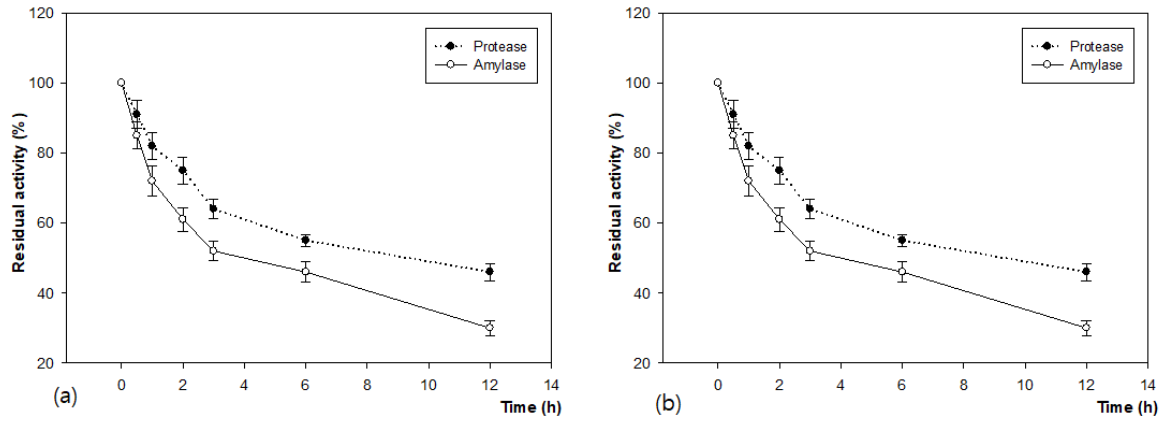
Figure 5. The stability of enzymes at acid and alkaline conditions: ( a ) pH 4.5 and ( b ) pH 12.